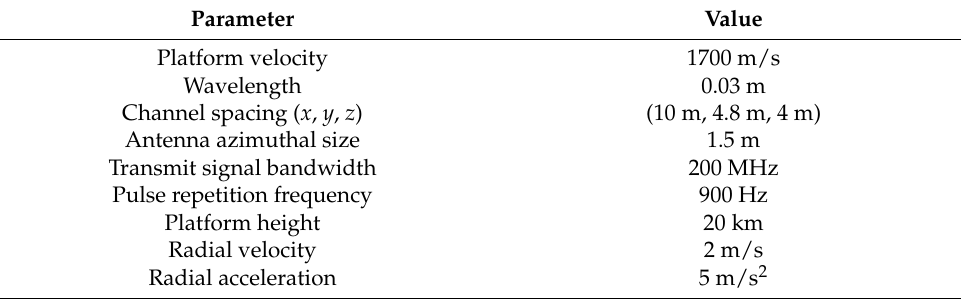
Table 1. Distributed SAR simulation system parameters.